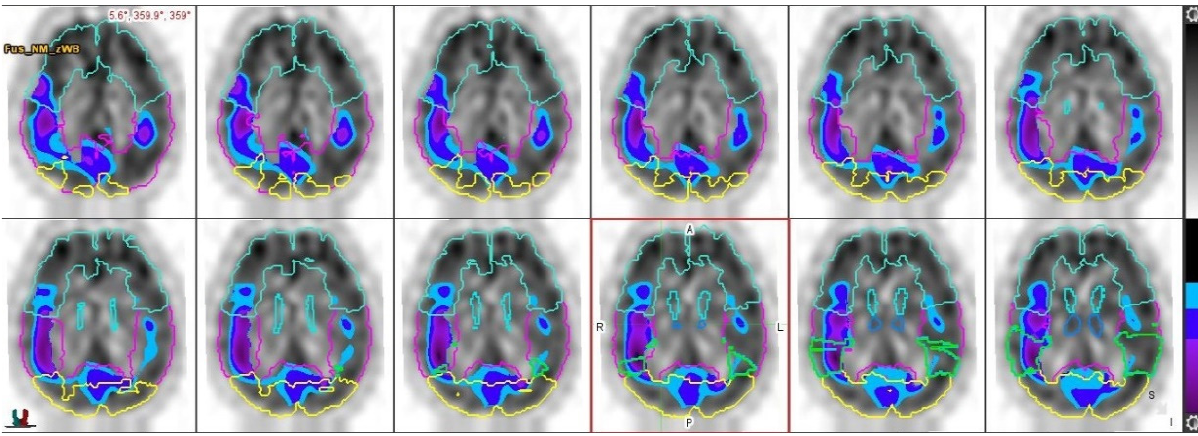
Figure 1. Presentation of performed autodetection of selected brain regions on SPECT transverse view, based on brain atlas template.